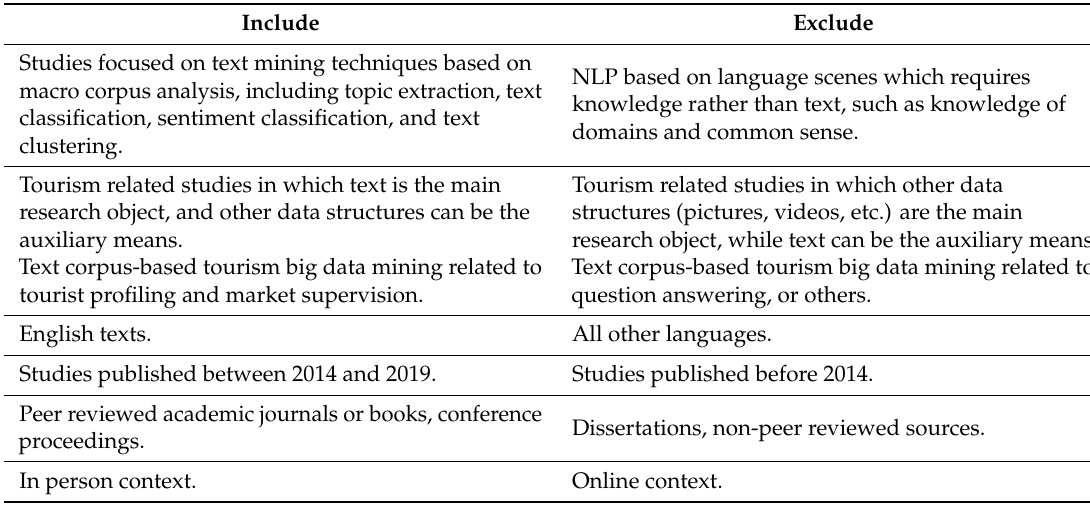
Table 1. Inclusion